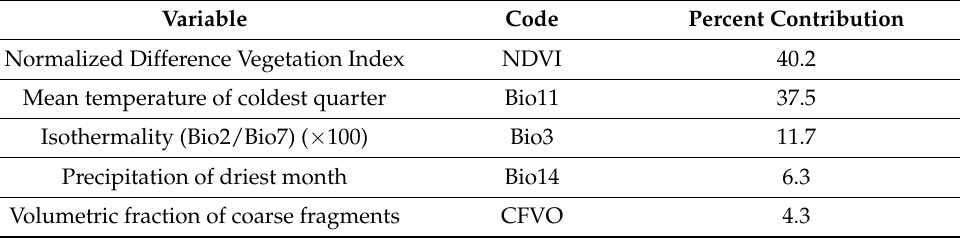
Table 3. Contribution (%) of the leading five environmental variables in species distribution modelling of Pinus gerardiana in the study